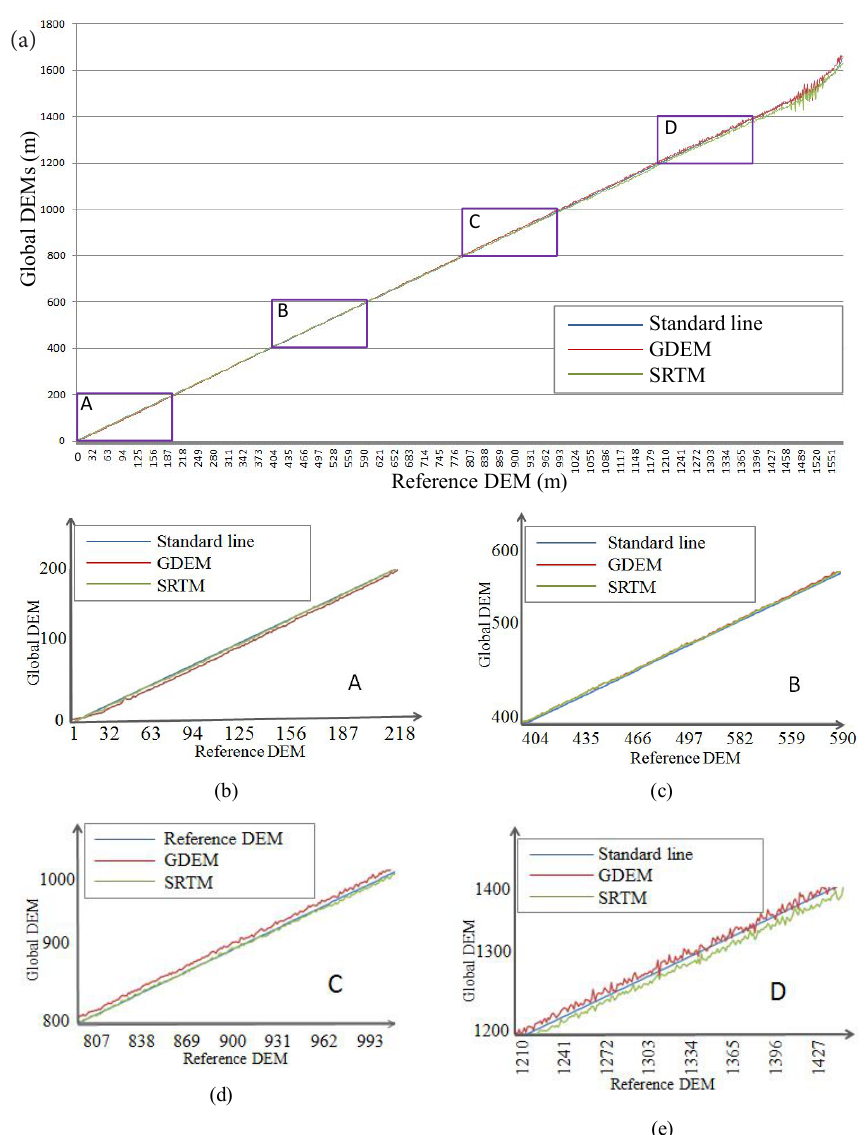
Fig. 9. Behaviour of GDEM and SRTM to Reference DEM in difference topographic contexts. 646 Figure 9. Behavior of GDEM and SRTM compared to the reference DEM in difference topographic contexts. (a) Whole area, (b) A area, (c) B area, (d) C area, (e) D